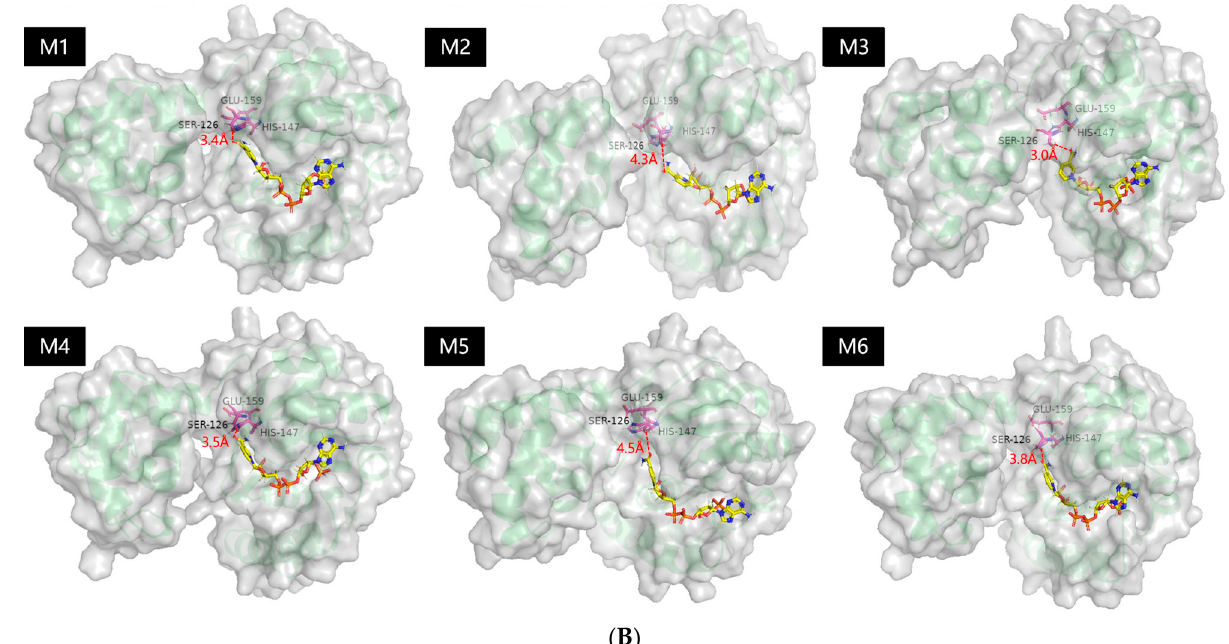
Figure 2. Simulation results of reasonable mutation candidates. ( A ) The binding conformation of NADP + in the enzyme; ( B ) The whole conformation of the ADH with NADP + . Mutants of M1 to M6 were D37G, D37G-V39S, D37G-A38T-V39K, Y36S-D37G-A38D, Y36S-D37G-A38G-V39K, and Y36S-D37G-A38D-V39K, respectively.